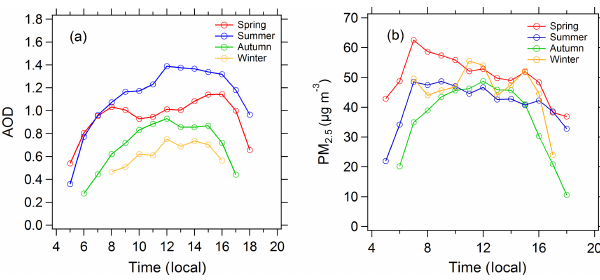
Figure 3. Diurnal cycles of (a) mean j (O 1 D) and (b) mean j (NO 2 ) in the four seasons under cloudless